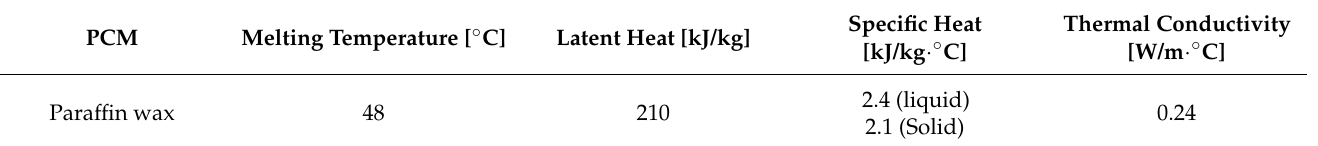
Table 2. Thermal specifications of paraffin wax [39].